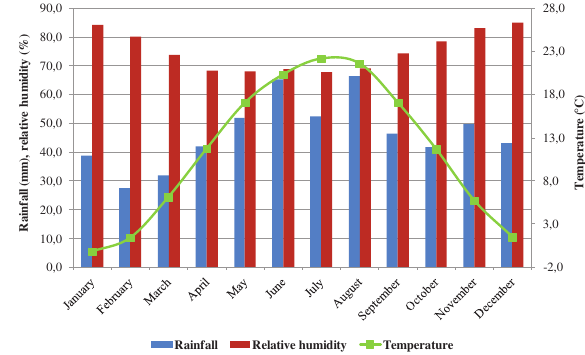
Figure 1. Climatic conditions based on the 38-year-old climatic database